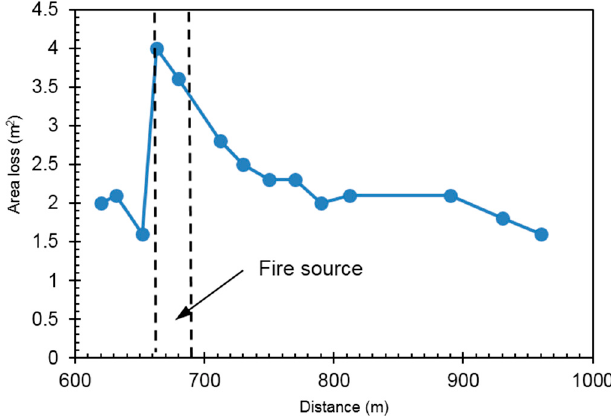
Figure 7. Area loss along longitudinal direction of the tunnel after fire.